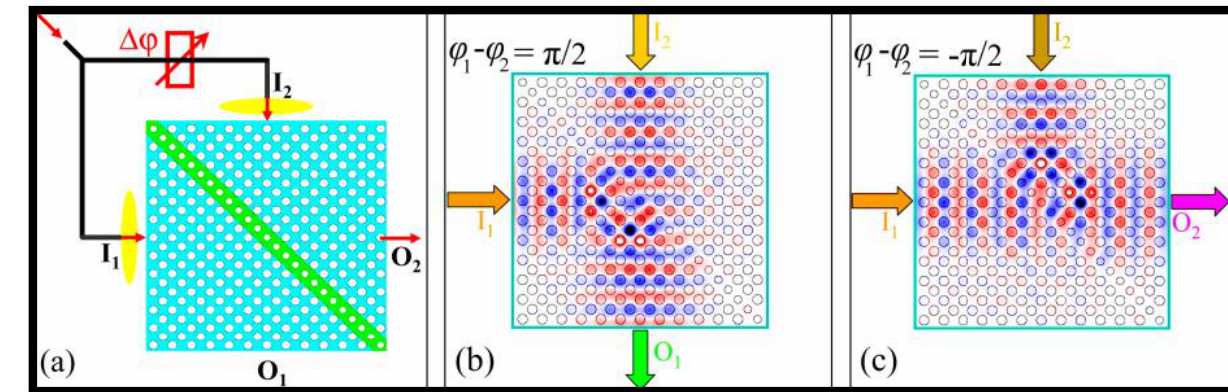
Figure 6. ( a ). The switch’s schematic representation. On the I/P faces I 1 and I 2 , two beams with different phases collide. The computed steady-state field pattern of the E-polarized mode at 0.194 (a/ λ ) when incoming beams propagate in the Г -M direction in ( b , c ). The phase difference between the two incident beams is adjusted to π /2 and − π /2, respectively, by the phase difference ϕ 1 − ϕ 2 [143]. Table 1. Evaluation of different kinds of non-PBG-based all-OLGs.